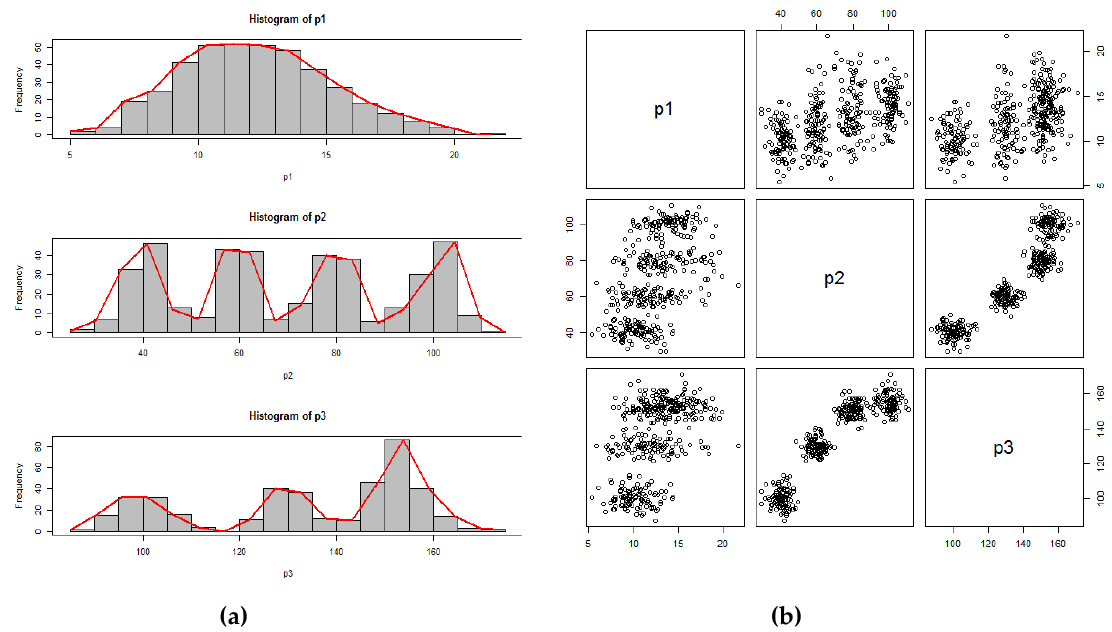
Figure 2. ( a ) Histograms and frequency polygons of the features in 3P_4C dataset ( b ) Pairwise scatter plots of the features in 3P_4C